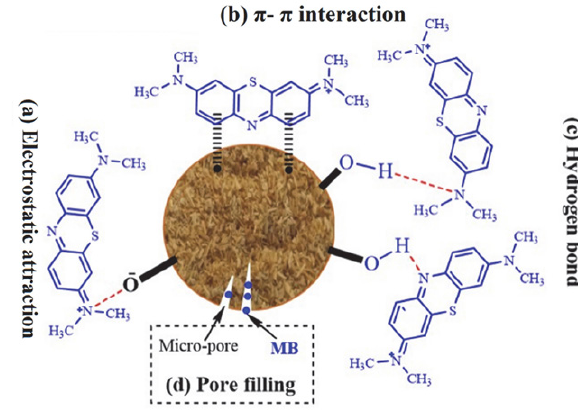
Fig. 10. FTIR spectra of SA-RPB (1) before and (2) after MB ad- sorption, and (3) pure